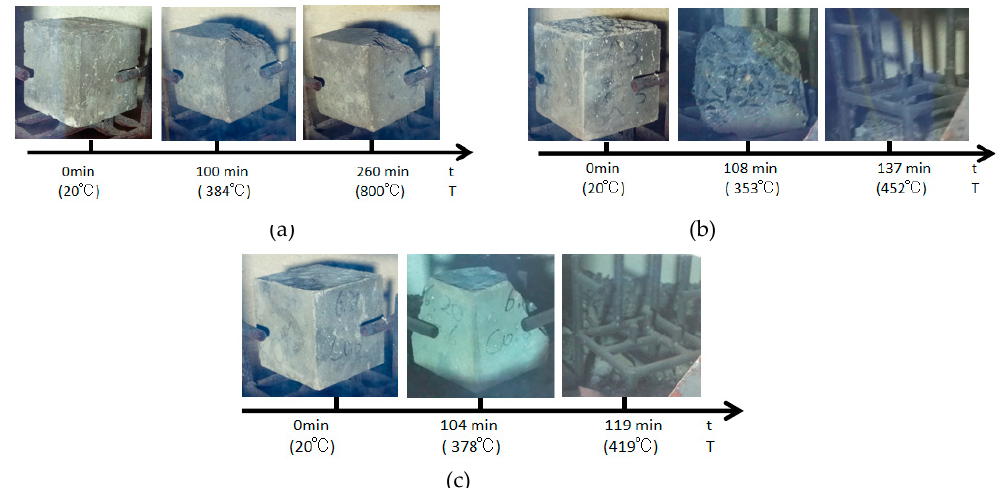
Figure 7. The burst process of the carbon fiber specimens with different dosages: ( a ) the burst process of C2, ( b ) the burst process of C4 and ( c ) the burst process of C6.